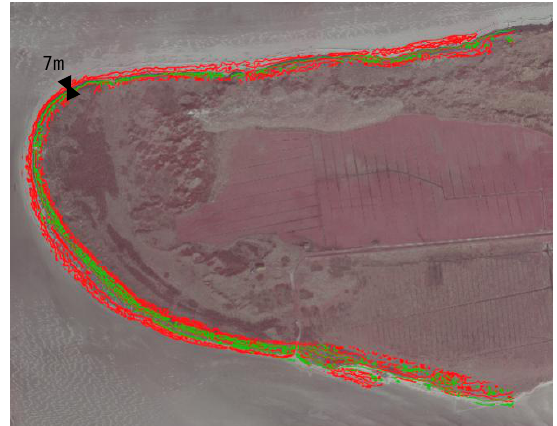
Figure 5. Edge image with the derived edges for 2004 (green) and 2010 (red) closed to the shoreline